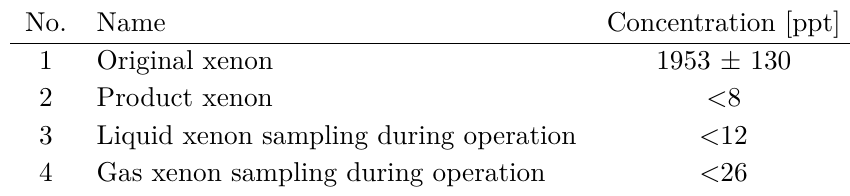
Table 7. nat Kr concentration measurement results (upper limit with 90% C.L. is